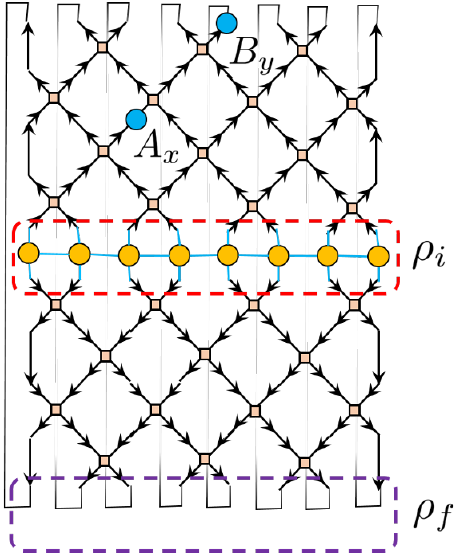
Figure 4 . This tensor network is a special case of the one in figure 3(c). The network here specifies a particular choice of ρ , namely a matrix product operator (MPO), which is depicted within the i dashed red lines. We have also put in purple dashed lines to illustrate the fact that taking a trace is equivalent to taking an inner product with a maximally mixed density matrix ρ normalization d (i.e., the Hilbert space dimension of a spatial